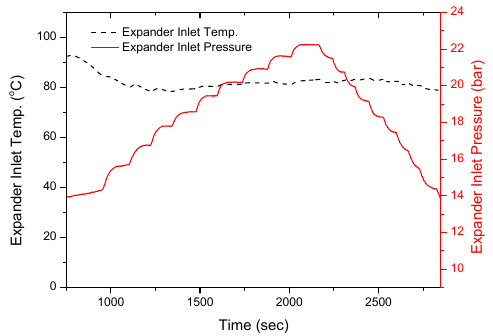
Figure 9. Expander inlet pressure and temperature over selected time interval.